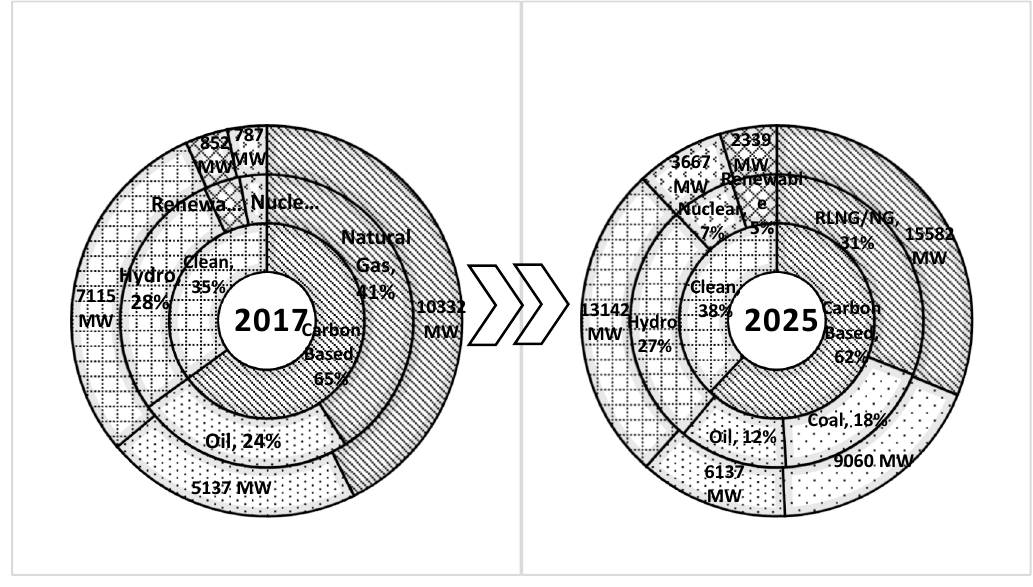
Figure 3. Pakistan’s energy fuel mix (2017–2025).